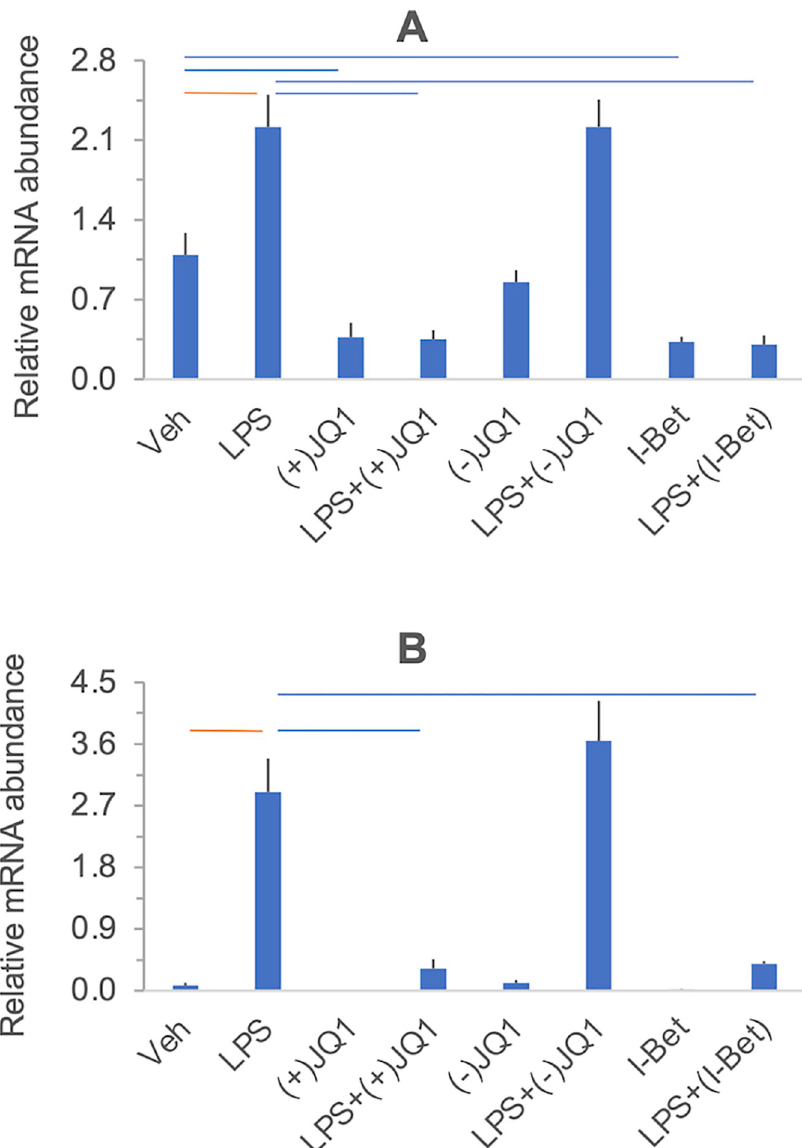
Fig 4. The effect of LPS and BET inhibitors on IL10 (Panel A) and IDO1 (Panel B) mRNA expression in DSCs. Primary DSC cultures were treated with vehicle, LPS, (+)-JQ1, (-)-JQ1, I-BET-762, and their combinations as indicated under the columns. Messenger RNA relative abundance was determined by qRT-PCR. Significant differences (at 5% FDR), highlighted in the heatmap in Fig 1, are indicated by the horizontal orange and blue lines. Further details and data presentation are described in Legend to Fig